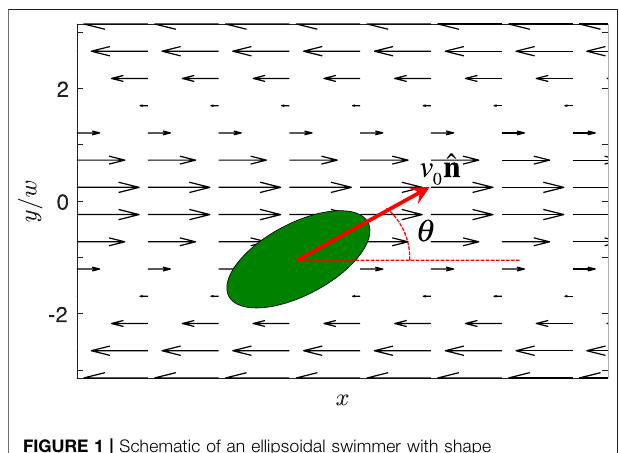
FIGURE 1 | Schematic of an ellipsoidal swimmer with shape parameter 0 < α < 1 in the Kolmogorov fl ow (not to